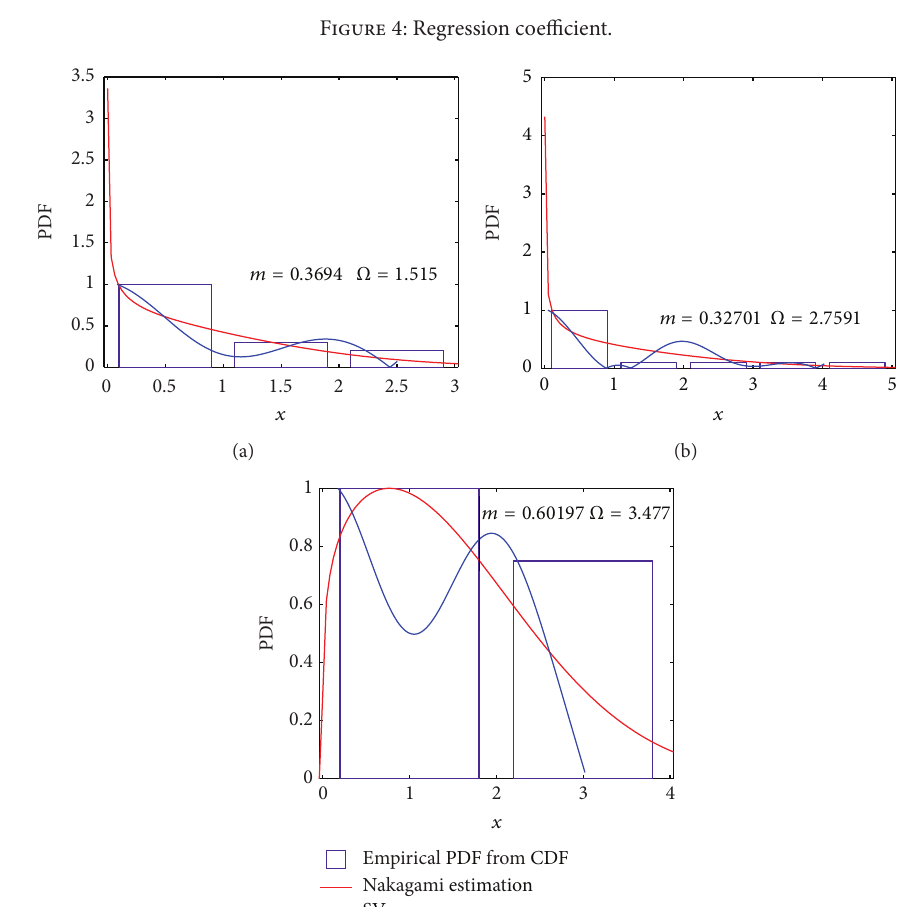
Figure 4: Regression coefficient.